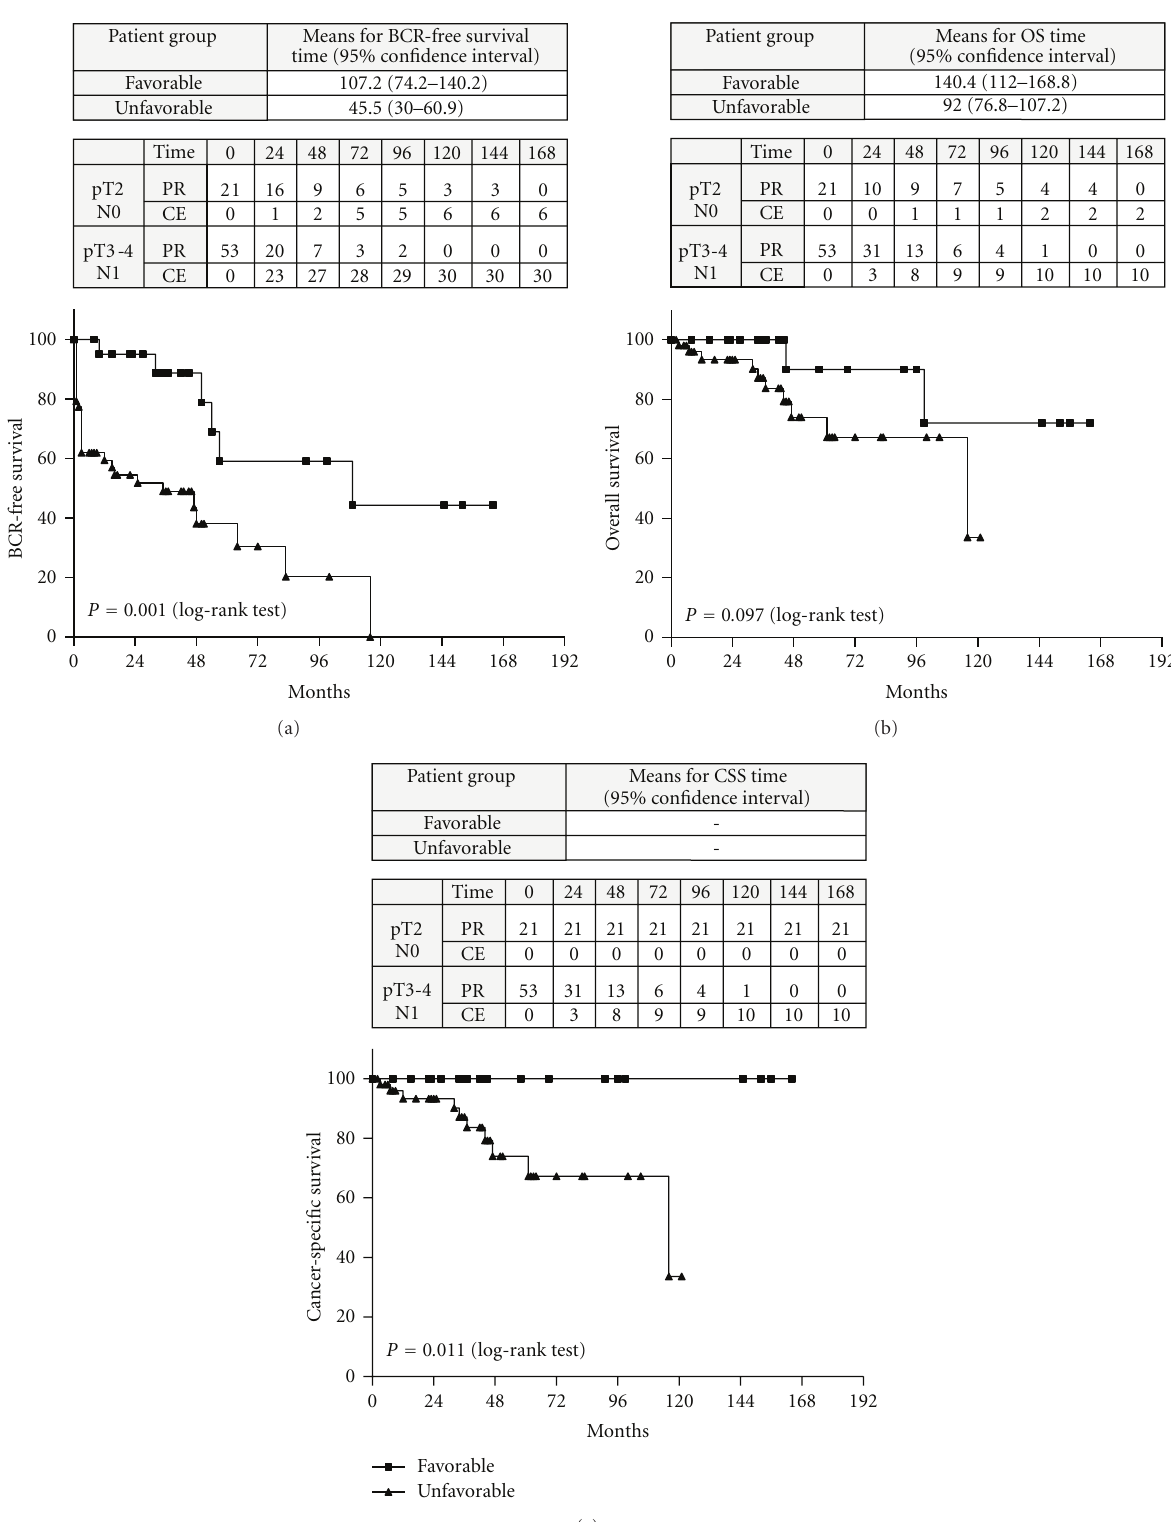
Figure 2: (a) Kaplan-Meyer curves distribution in group B: comparison between patients with favorable versus unfavorable prognostic features with regard to BCR-free survival rates. PR: patients at risk; CE: cumulative number of events. (b) Kaplan-Meyer curves distribution in group B: Comparison between patients with favorable versus unfavorable prognostic features with regard to OS survival rates. PR: patients at risk; CE: cumulative number of events. (C) Kaplan-Meyer curves distribution in group B: comparison between patients with favorable versus unfavorable prognostic features with regard to CSS survival rates. PR: patients at risk; CE: cumulative number of